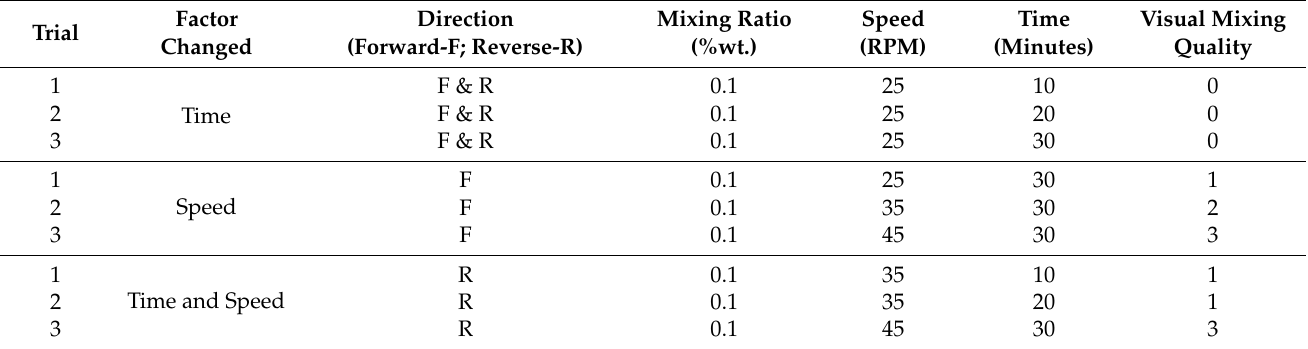
Table 3. Mixing process parameters.